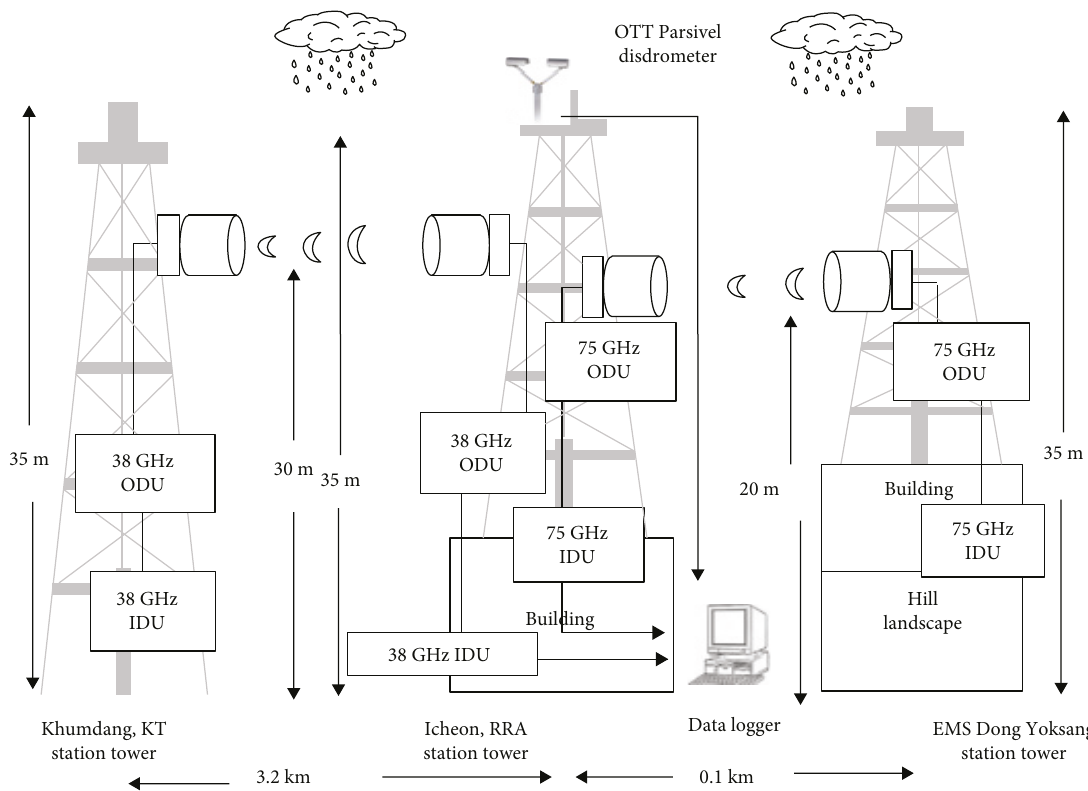
Figure 7: Experimental setup for rain attenuation and rain rate measurement